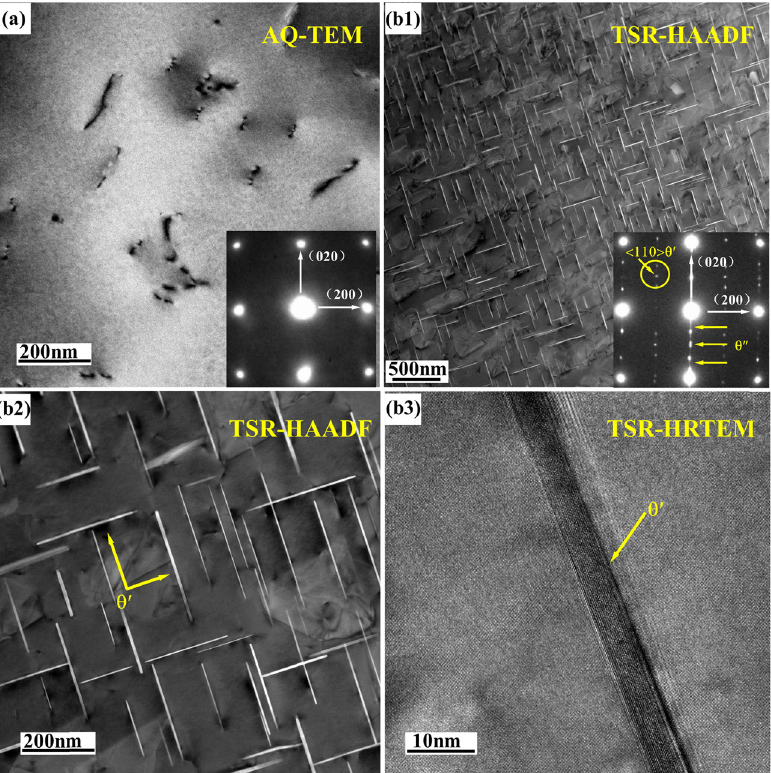
Figure 8: TEM/STEM images and corresponding SAED patterns of precipitated phase characteristics: ( a ) AQ piece and ( b1 – b3 ) TSR